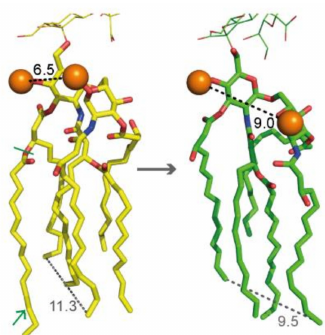
Figure 3. Structures of hexa-acylated and penta-acylated lipid A depicted as yellow and green sticks, respectively (red: oxygen, blue: nitrogen). Phosphates are shown as orange spheres, and distance measurements are shown as dashed lines. The green arrow indicates the myristic acid residue of hexa-acylated lipid A, and the green bar indicates its binding site in lipid